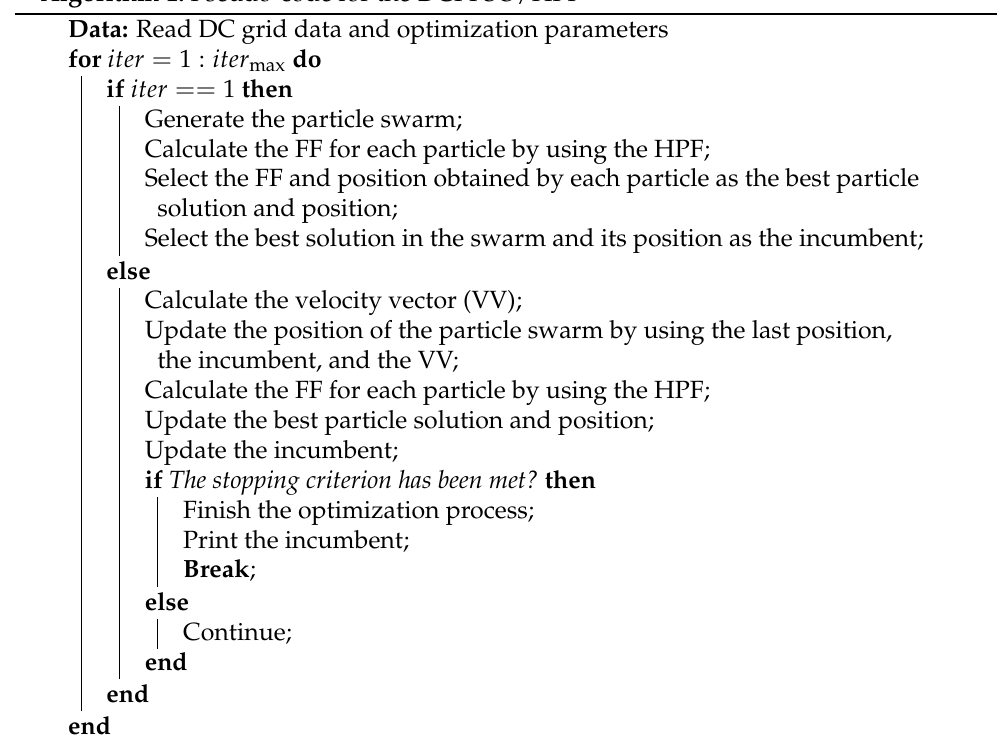
Algorithm 1: Pseudo-code for the DCPPSO/HPF Data: Read DC grid data and optimization